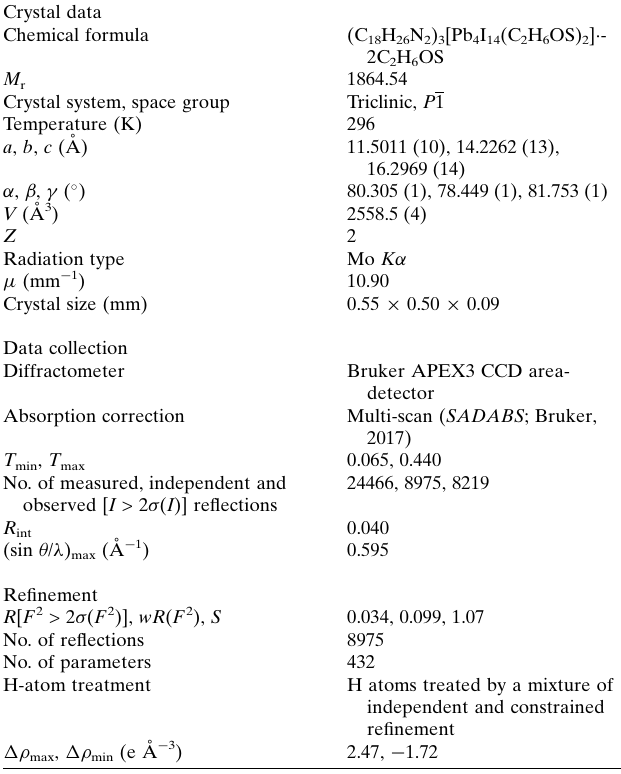
Table 3 Experimental details. Crystal data Chemical